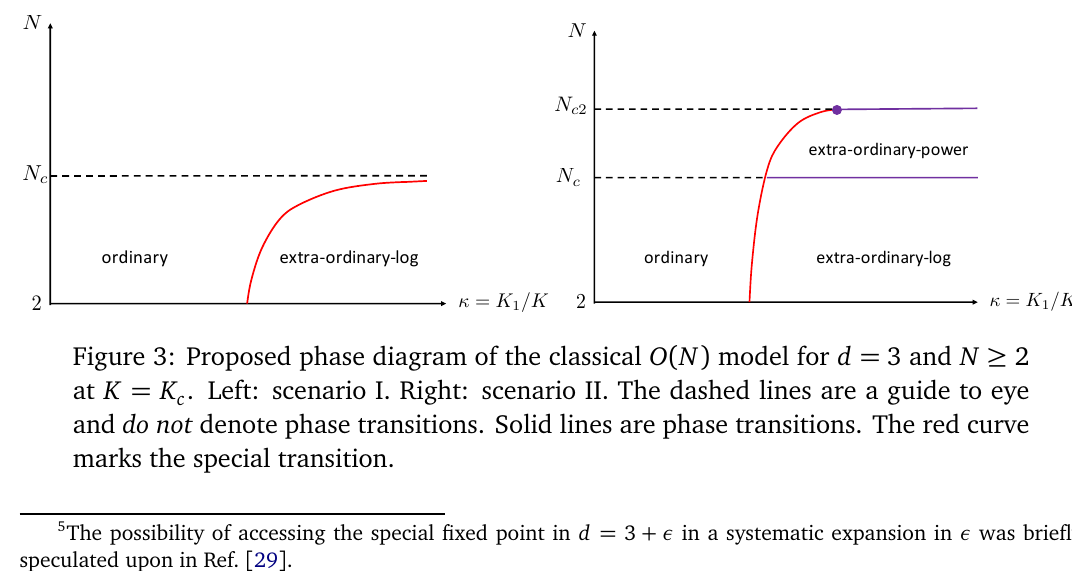
Figure 2: Proposed phase diagram of the classical O ( N ) model for d = 3 and N > 2. Left: N < N in scenario I or N < N c N > N in scenario II. c 2